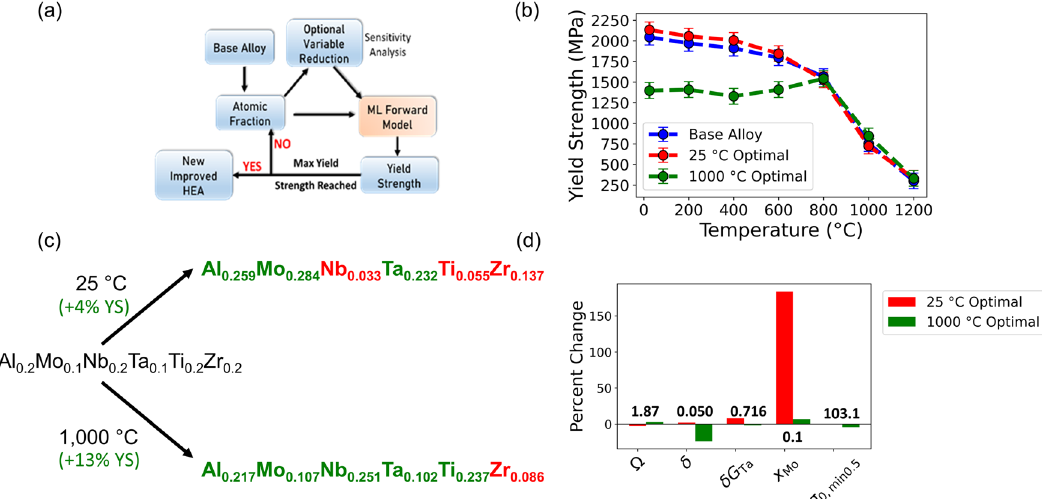
Fig. 4 Optimization of AlMoNbTaTiZr for yield strength improvement. a The fl owchart outlines the steps for optimizing the HEA composition from a base HEA. The only input required for the model is a base HEA composition; b yield strength vs. temperature pro fi le for the original base alloy and the two optimized alloys. c comparison of the element fractions for the original base alloy and the alloys optimized for 25 °C and for 1000 °C. Elements that were increased are shown in green text, while elements that were decreased are shown in red text; d percent change, relative to the base alloy, of each feature which serves as a direct input to the yield strength model. The numbers in bold black font are the values of each feature in the base alloy. A 95% con fi dence level error (±94 MPa) is shown for